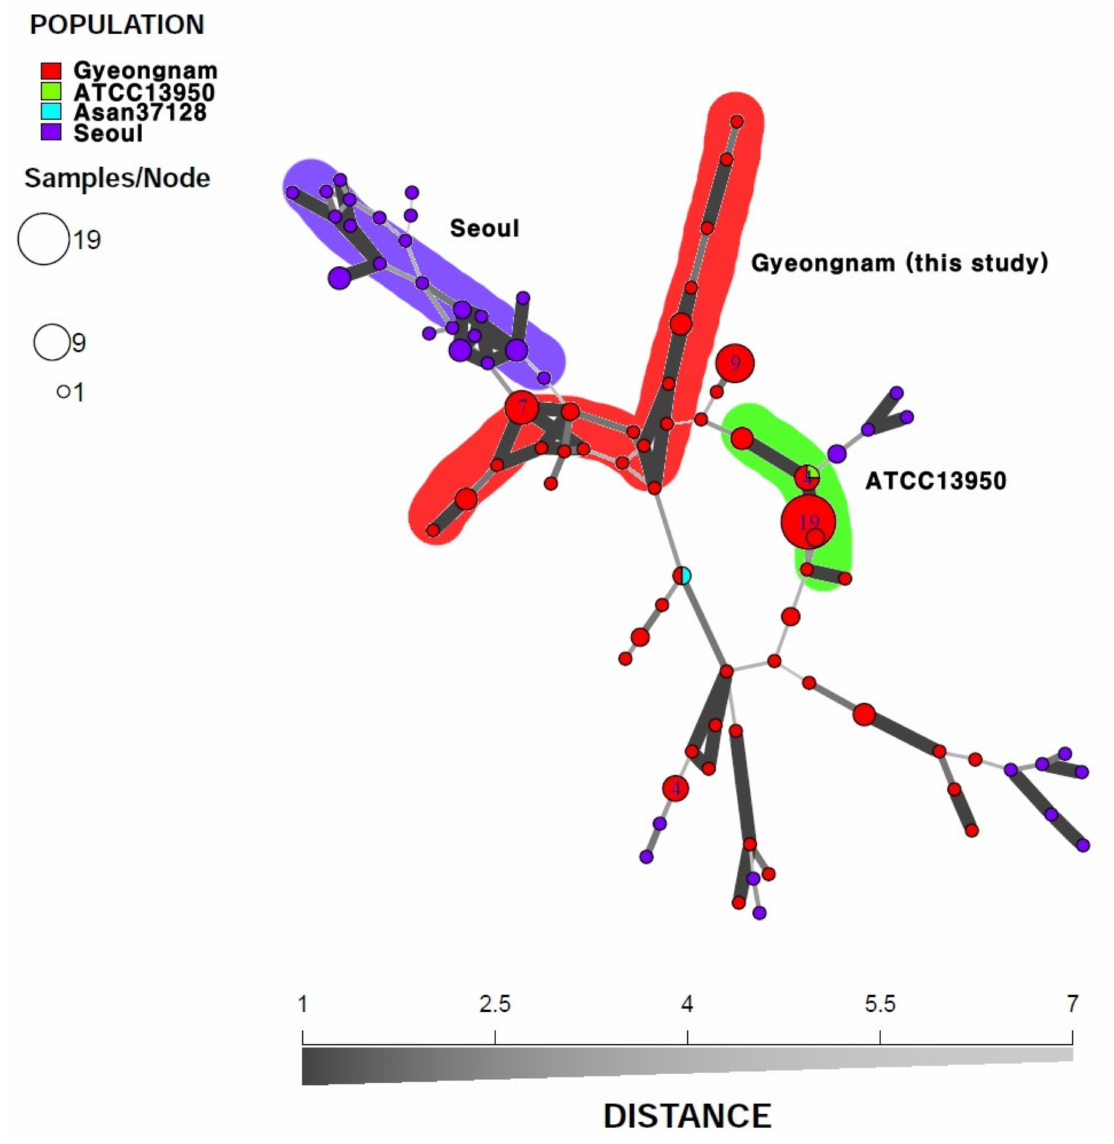
Figure 5. Minimum spanning tree of the variable number tandem repeat (VNTR) and VNTR-mycobacterial interspersed repetitive units (MIRU) types for the 146 M. intracellulare clinical strains from Korea. The minimum spanning tree was generated by R program using 21 VNTR and VNTR-MIRU loci, excluding VNTR 11 and MIRU 3 of previous studies and this study. The data of previous domestic studies (n = 45, Seoul) and the results from this study (n = 101, Gyeongnam) and reference strains (ATCC 13950 and Asan 37128) were analyzed in this